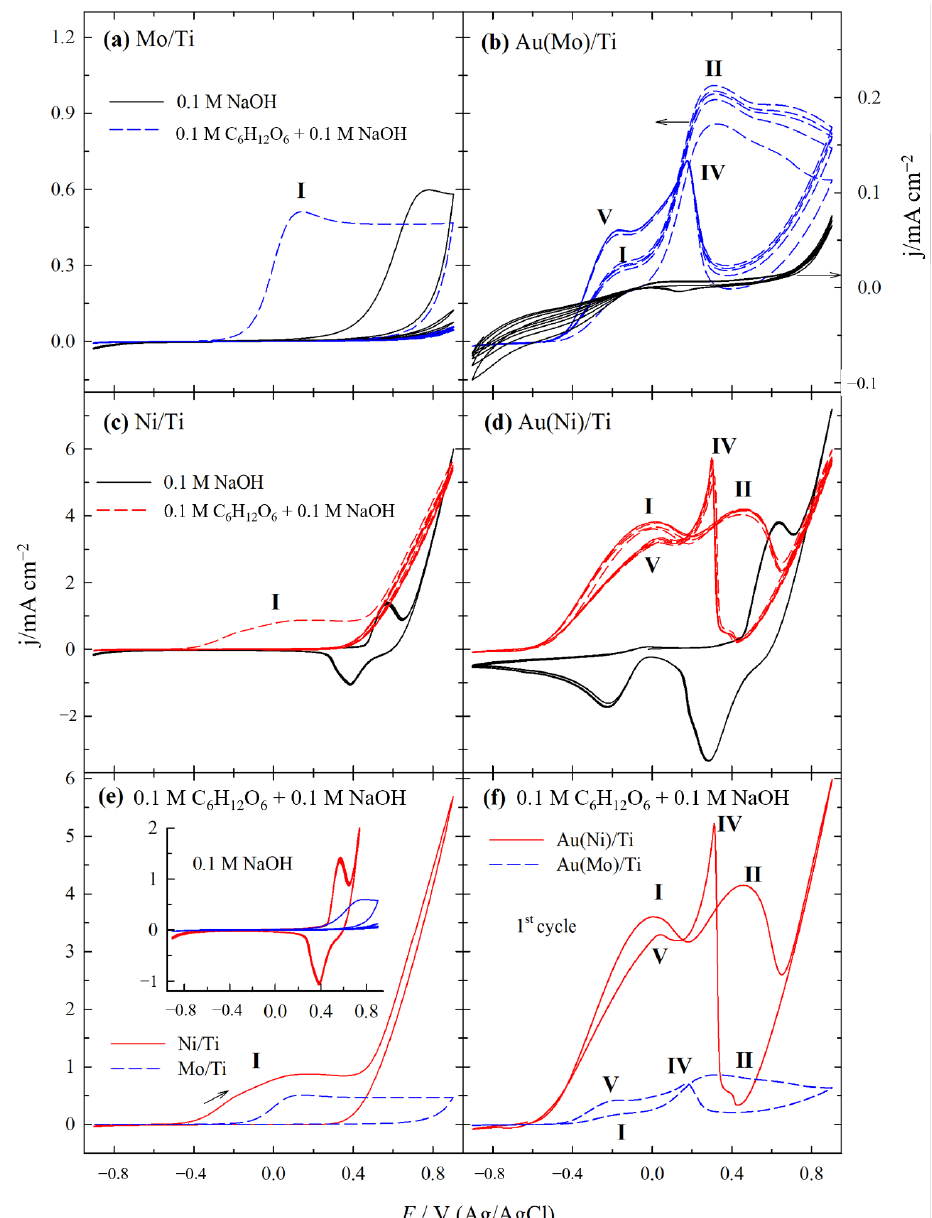
Figure 5. CVs recorded on Mo/Ti ( a ), Au(Mo)/Ti ( b ), Ni/Ti ( c ), and Au(Ni)/Ti ( d ) catalysts in the 0.1 M NaOH solution (solid line) and in that containing 0.1 M glucose (dashed line) at 25 °C at an elec- trode potential scan rate of 50 mV s − 1 . First scans of CVs recorded in 0.1 M NaOH + 0.1 M C 6 H 12 O 6 on Ni/Ti (solid line) and Mo/Ti (dashed line) catalysts ( e ), and on Au(Ni)/Ti (solid line) and Au(Mo)/Ti (dashed line) catalysts ( f ) for the same conditions as in ( a – d ). The insert in ( e ) shows CVs recorded in 0.1 M NaOH on Ni/Ti and Mo/Ti catalysts.